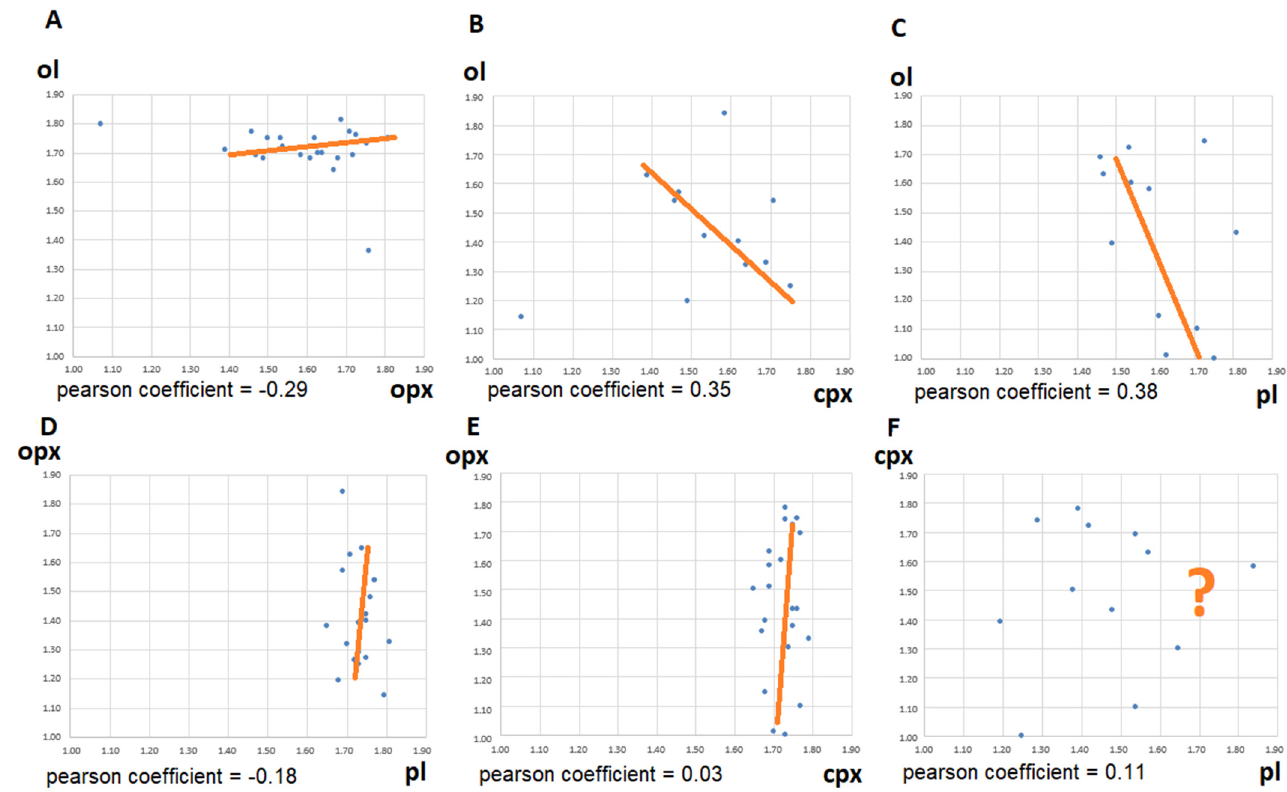
Figure 7. Correlation of the fractal dimension for couples: olivine—orthopyroxene ( A ), olivine—clinopyroxenes ( B ), olivine—plagioclase ( C ), orthopyroxene—plagioclase ( D ), orthopyroxene—clinopyroxenes ( E ), orthopyroxene—plagioclase ( F ). Abbreviations: ol—olivine; opx—orthopyroxene; cpx—clinopyroxene; pl — plagioclase.